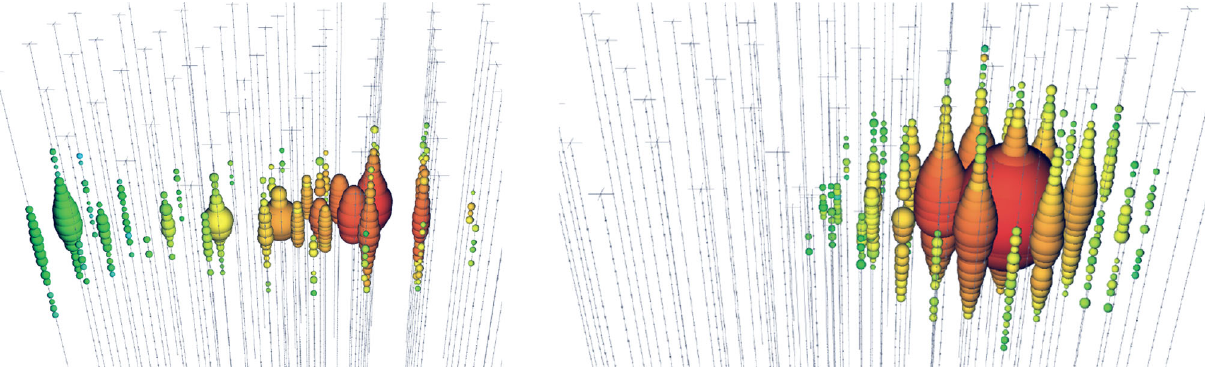
Fig. 2 Two examples of events observed with IceCube. The left plot shows a muon track from a ν μ interaction crossing the detector. Each coloured dot represents a hit DOM. The size of the dot is proportional to the amount of light detected and the colour code is related to the